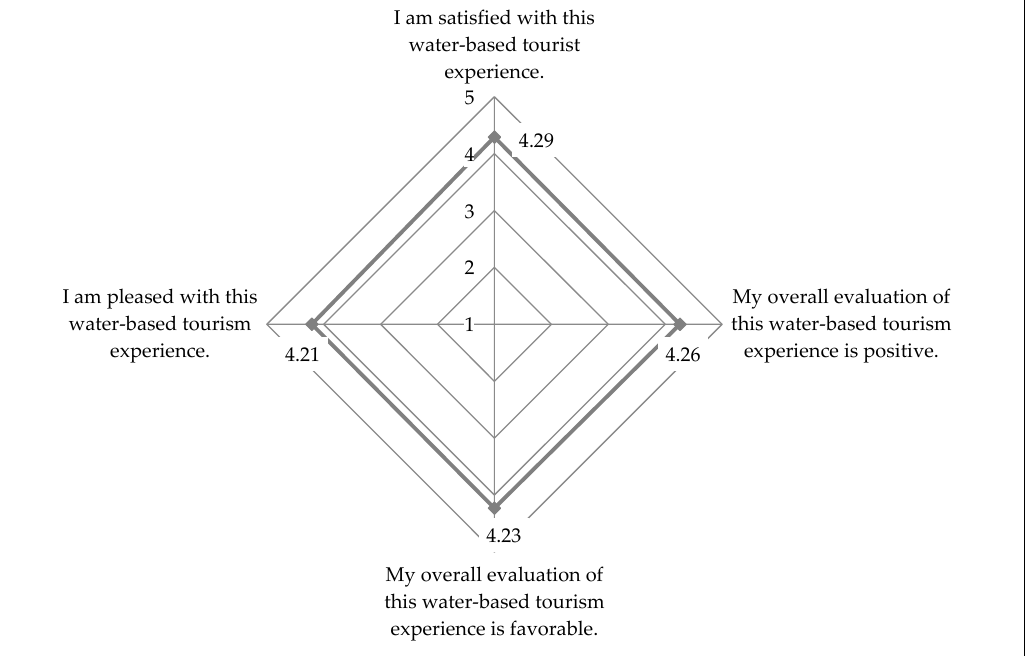
Figure 7. Assessment of the variable Satisfaction with the